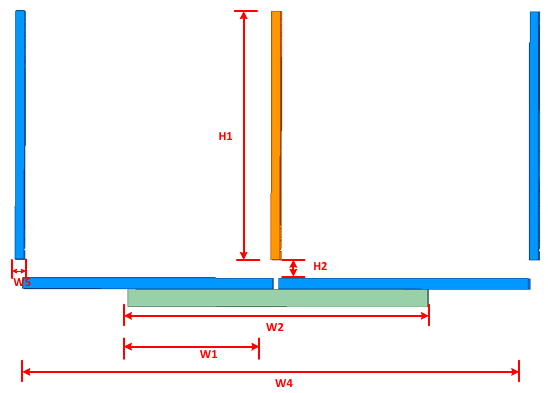
Figure 5. The paramount view of the coupling structure. The final output current of this system is 20 A; when the system is in resonance, the current flowing through the coil will be greater than the output current. Taking into account the skin effect, the larger the diameter of the copper wire due to AC resistance caused, the greater the loss here. Take the peak current flowing through the coil, which is output current, and choose the diameter, w, for a 3.65 mm Leeds wire winding coil. In this study, to facilitate the processing of the mold and minimize the size of the coil, the turn spacing, p, was set to 1 mm. Assuming that the self-inductance of the transmitting and receiving coils are L 1 and L 2 , and the current flowing through them is I 1 and I 2 , the transferred power, P , of the coils can be easily calculated according to the equivalent model of mutual inductance of the coils as